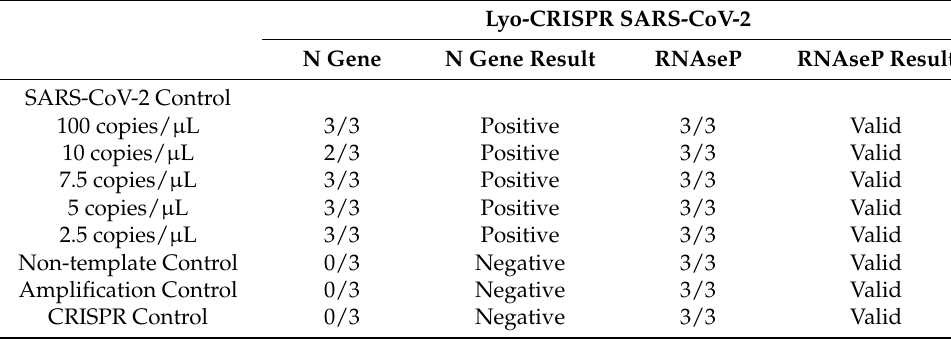
Table 2. Analytical sensitivity evaluation of Lyo-CRISPR SARS-CoV-2 kit.